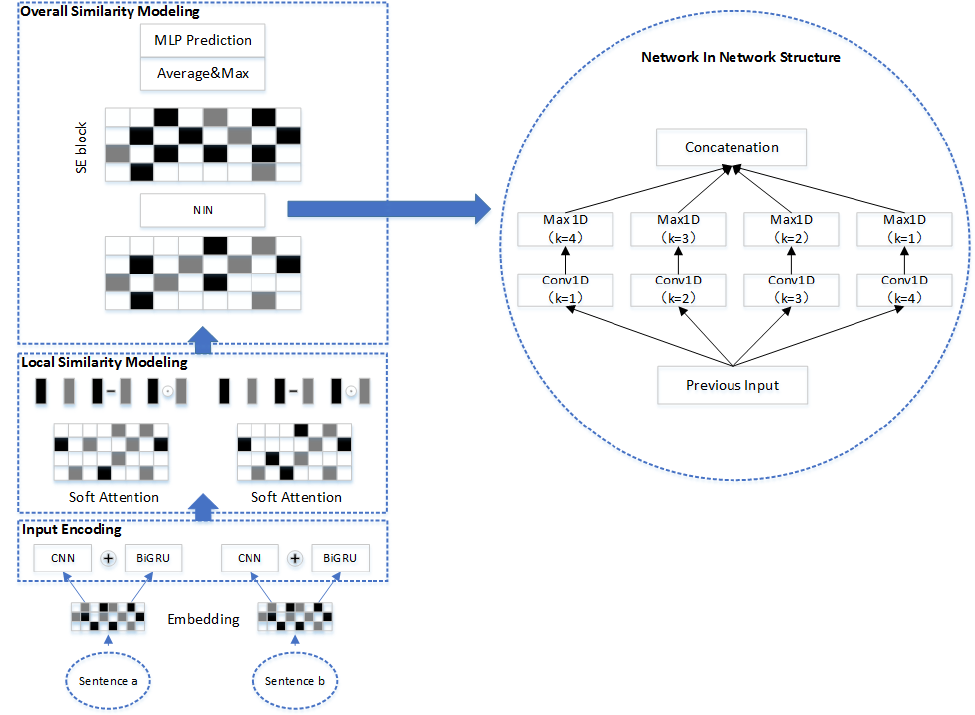
Fig. 1. Structure of the ABOEN